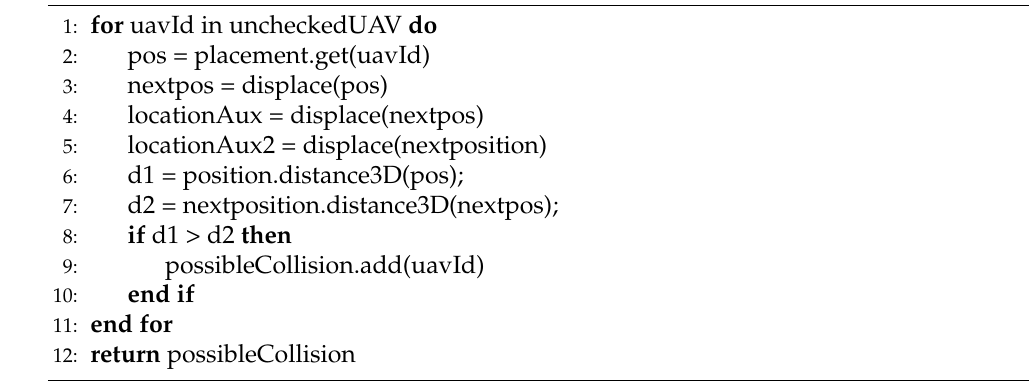
Algorithm 4 checkConvergingLines(position, nextposition, uncheckedUAV)